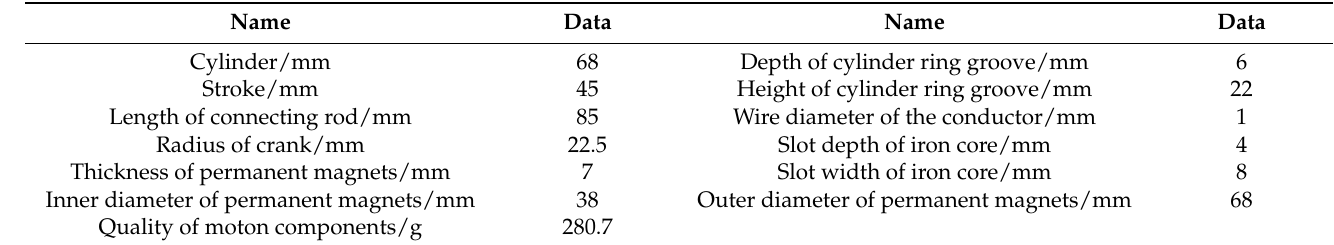
Table 1. Overall structural parameters of the PMPMEE.